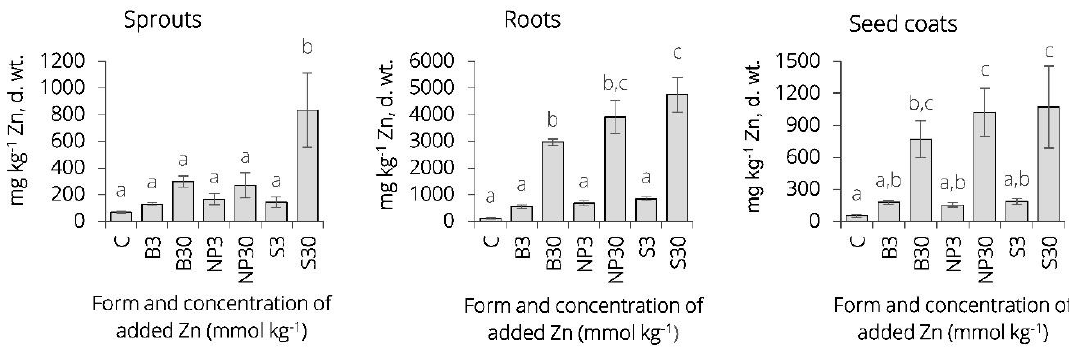
Figure 3. Zinc concentration (mg kg − 1 d. wt.) in roots, seed coats and sprouts of barley ( Hordeum vulgare L.) cultivated for seven days in bulk ZnO–, ZnO-NP– and ZnSO 4 –amended soil pots and determined via flame atomic absorption spectrometry (FAAS). Each set of measurements involves sprout/seed coat/root biomass of seven plants ± SD (three replicates). a , b , c letters indicate statistically similar means between the groups as assessed by a one-way ANOVA with Tukey post-hoc test. For characteristics of C, B3, B30, NP3, NP30, S3, S30, see Table 3. Some amount of zinc is passively adsorbed onto the surface of the seeds indicating that only a limited amount of metal is absorbed by the roots and there is a substantial proportion of zinc ions that might be adsorbed onto the root surface. The results also indicate that some differences in Zn concentration in plant tissues, particularly in roots, can be attributed to particle size. During the dissolution of ZnO in the root zone, nanosized particles are absorbed more readily than larger sized particles (bulk ZnO). The plants treated with ZnO-NP show higher concentrations of Zn in roots, although the differences in measured concentrations of Zn in root tissues between the groups treated with ZnO-NP and those treated with bulk ZnO are not significant.